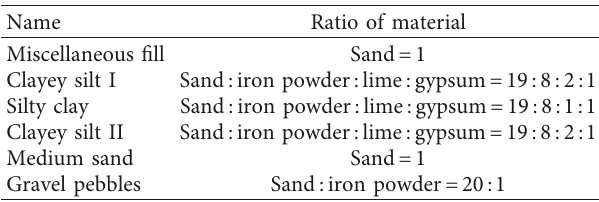
Table 3: Material proportion of each stratum.